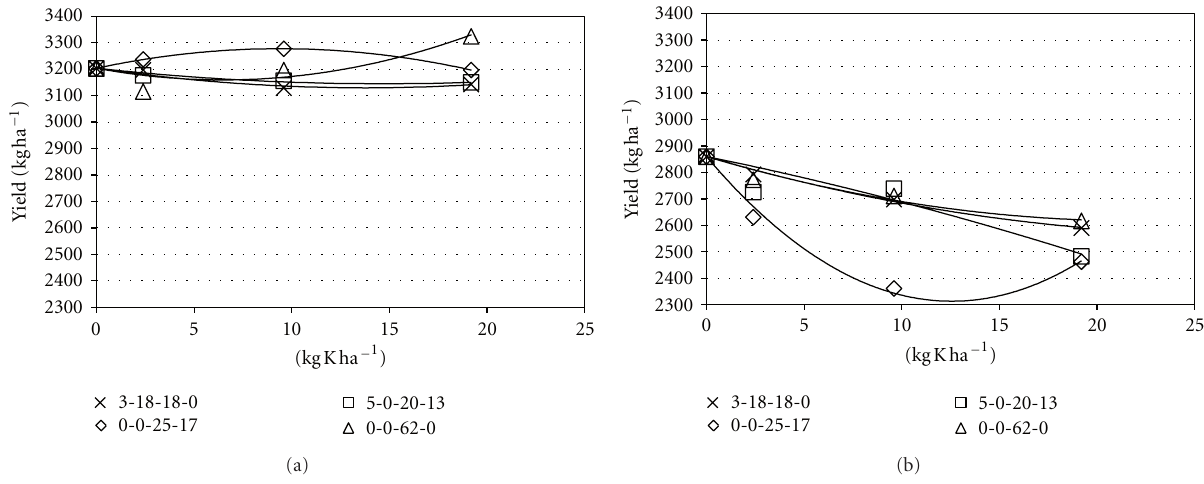
Figure 2: Soybean grain yield response to K-fertilizer additives (%N-%P 2 O 5 -%K 2 O-%S) of 3-18-18-0 ( y = − 1 . 4832 x 2 − 10 . 738 x + 3203, R 2 = 0 . 92), 0-0-25-17 ( y = − 0 . 8783 x 2 + 15 . 749 x + 3203, R 2 = 0 . 99), 5-0-20-13 ( y = 1 . 3693 x 2 − 7 . 9878 x + 3203, R 2 = 0 . 94), or 0-0-62- 0 ( y = 8 . 0129 x 2 − 13 . 635 x + 3203, R 2 = 0 . 80) applied alone to weed-free plots (a) and with glyphosate to weedy plots (b) for 3-18-18-0 ( y = 2 . 4953 x 2 − 21 . 474 x +2860, R 2 = 0 . 99), 0-0-25-17 ( y = 8 . 0594 x 2 − 87 . 005 x +2860, R 2 = 0 . 98), 5-0-20-13 ( y = 10 . 901 x 2 − 15 . 061 x +2860, R 2 = 0 . 85), and 0-0-62-0 ( y = 4 . 8315 x 2 − 21 . 957 x + 2860, R 2 = 0 . 94) at Novelty in 2005. The nontreated, weed-free, and glyphosate plus nonionic surfactant plus diammonium sulfate grain yields were 1070, 3200, and 2750 kgha − 1 , respectively. Comparisons between figures are valid. The LSD ( P = 0 . 01) was 320 kg ha − 1